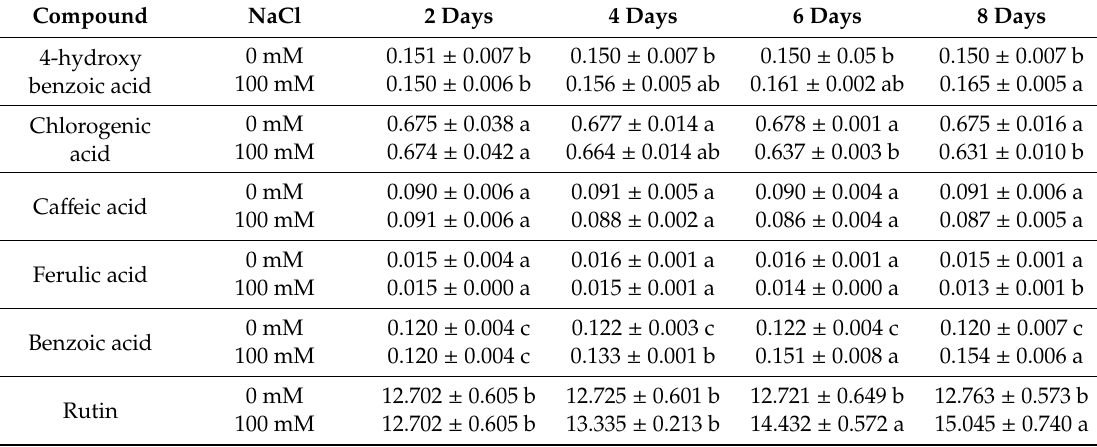
Table 3. The accumulation of phenolic compounds under salt stress in tartary buckwheat plants (Average ± STDEV, mg / g dry weight.) The means and standard deviations were obtained from three independent experiments. Letters a–c indicate significant di ff erences ( p <